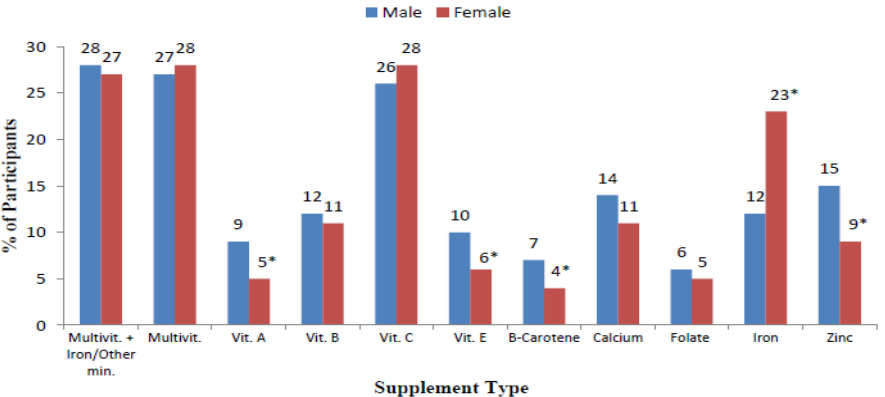
Figure 1. Sex differences between types of supplements used ( n = 1302). * Denotes significant association ( p ≤ 0.05) between sex and supplement use—chi square test.